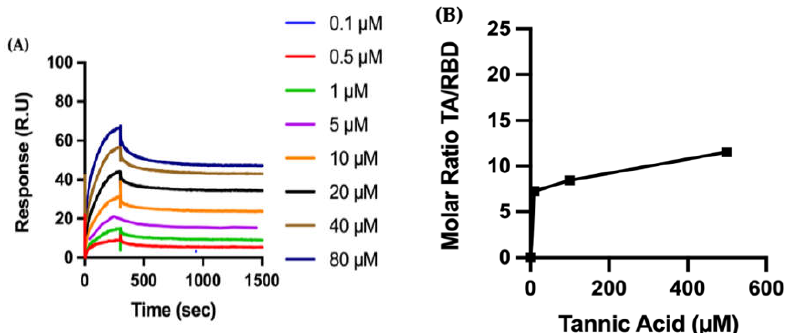
Figure 2. Biophysical characterization of the molecular interaction between TA and RBD: ( A ) Binding of polyphenol TA to immobilized RBD by surface plasmon resonance (SPR). The recombinant protein RBD (N501Y) is immobilized on a carboxymethylated dextran (CM5) sensor chip, and increasing concentrations of TA are injected to evaluate binding kinetics. ( B ) RBD is adsorbed to a gold quartz crystal microbalance with dissipation monitoring (QCMD) sensor, and various concentrations of TA are flowed over the surface for 30 min. TA adsorption is shown by the dimensionless molar ratio of adsorbed TA from solution to adsorbed RBD. The initial slope is a measure of the affinity of TA to RBD.